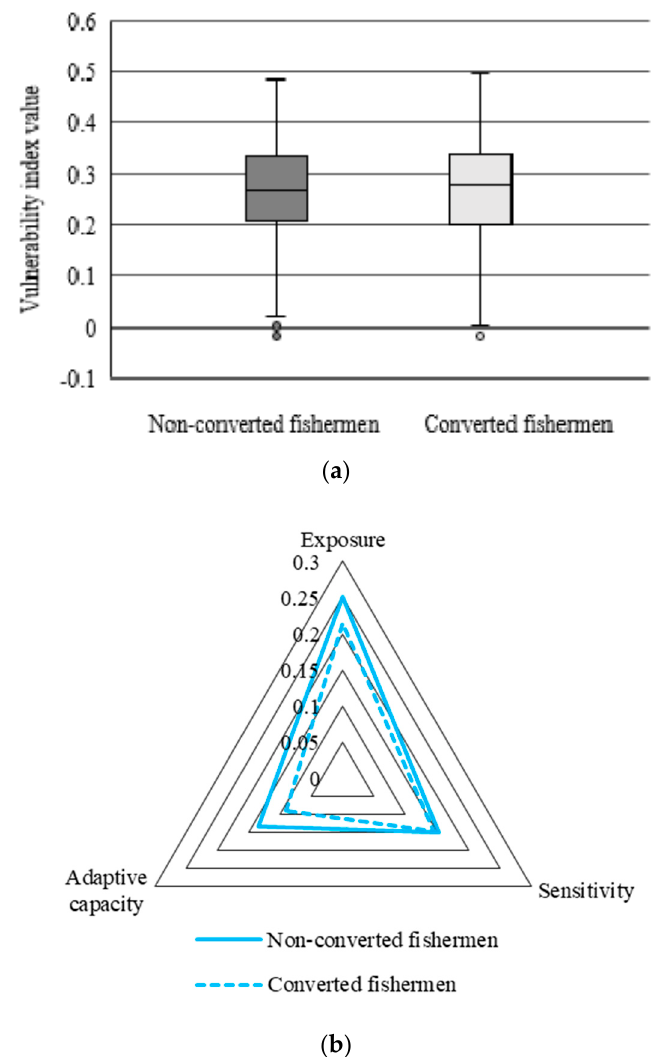
Figure 3. The LVI for non-converted and converted fishermen: ( a ) Box plot of the LVI values; ( b ) Radar chart of the exposure index, sensitivity index, and adaptive capacity index.